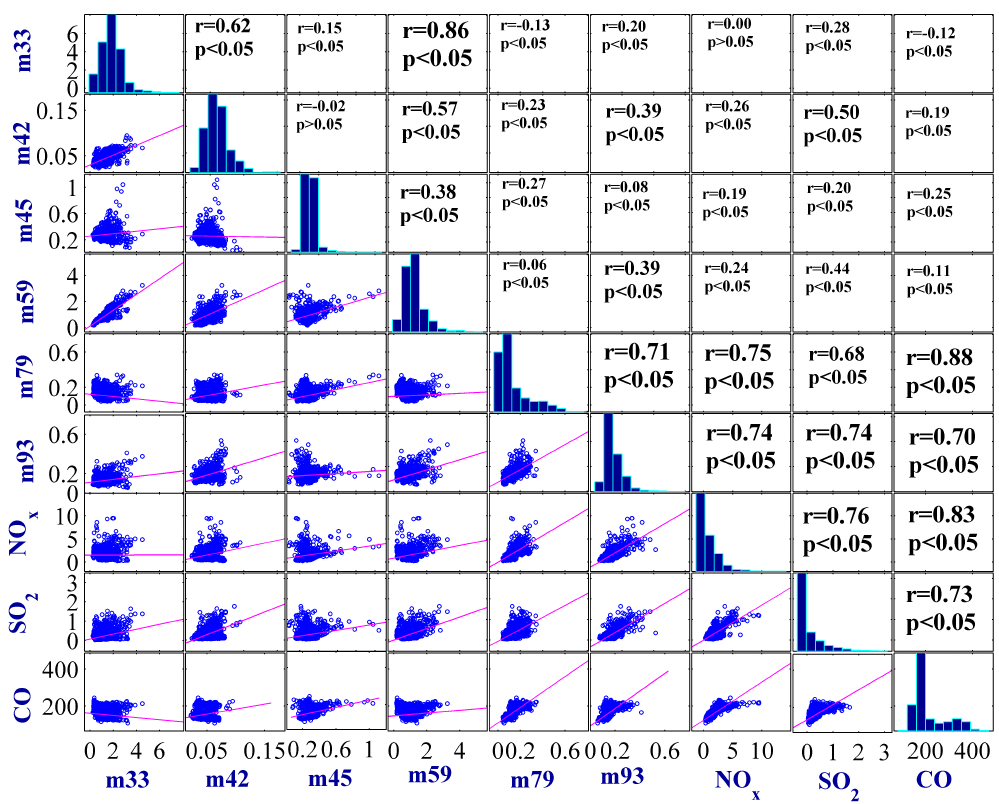
Figure A1. The correlation matrix, Pearson’s correlation coefficients and p values between calculated trace gases ( m 33 (methanol) m 42 (acetonitrile) m 45 (acetaldehyde) m 59 (acetone) m 79 (benzene) m 93 (toluene) NO x (nitrogen oxides) CO (carbon monoxide) and SO 2 (sulfur dioxide)) correlations. Diagonal in the matrix is distribution of